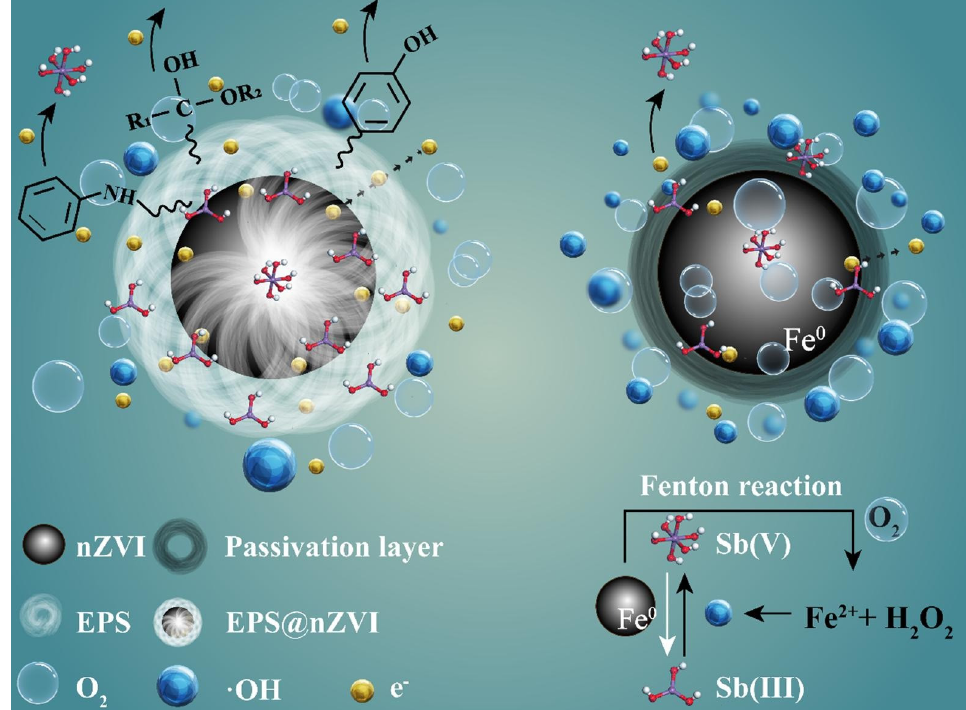
Figure 11. E ff ect of extracellular polymeric substances (EPS) on the removal of Sb(V) ions from solution by zerovalent iron particles (nZVIs). (left) Passivated nZVI shows much higher levels of removal. Reprinted from Yang-Yang et al. [164] with permission from Elsevier.